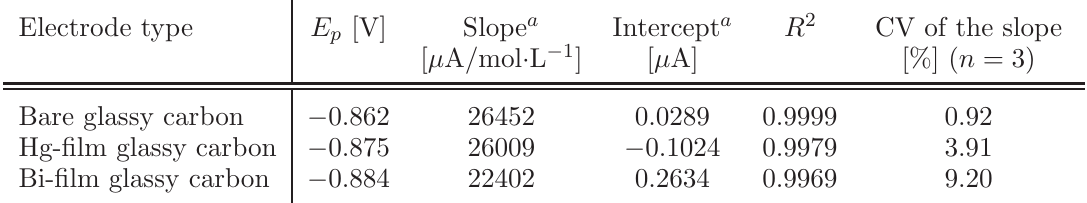
Table 1 Cathodic differential pulse voltammetric calibration curve parameters for colchicine using the three different types of electrodes.